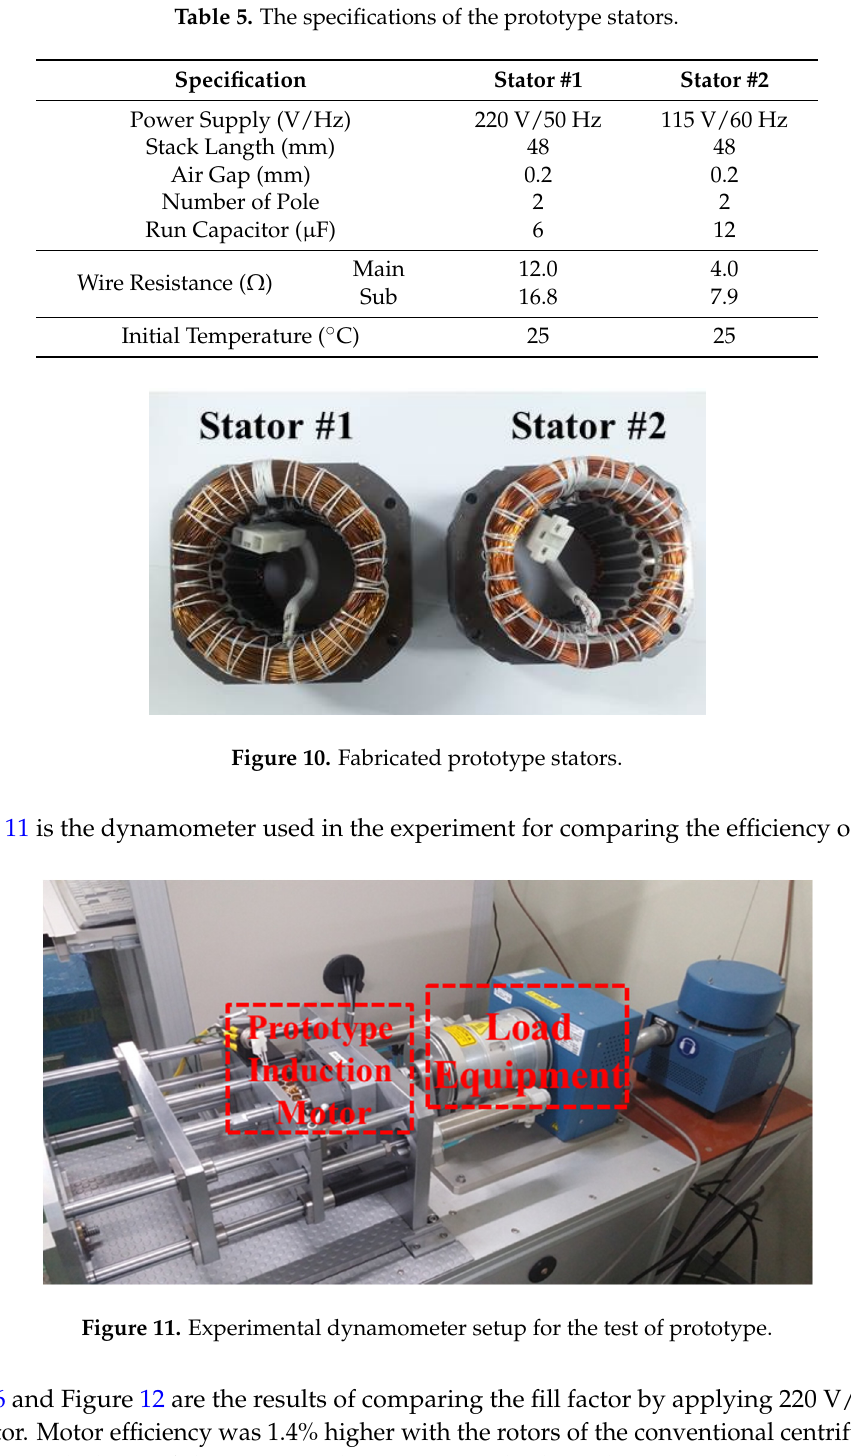
Figure 11. Experimental dynamometer setup for the test of prototype.